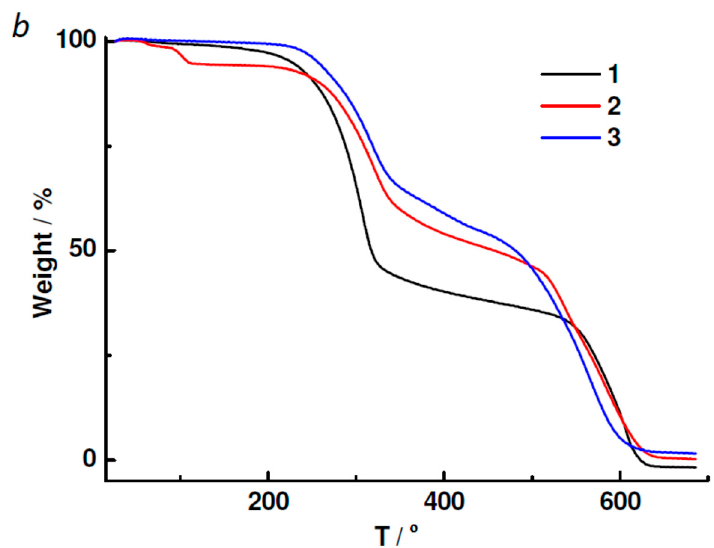
Figure 4. ( a ) Powder XRD patterns of 1 – 3 . (T = theoretical profile referenced to the experimentally determined single-crystal XRD pattern; E = experimental data). ( b ) TGA curves of 1 – 3 .